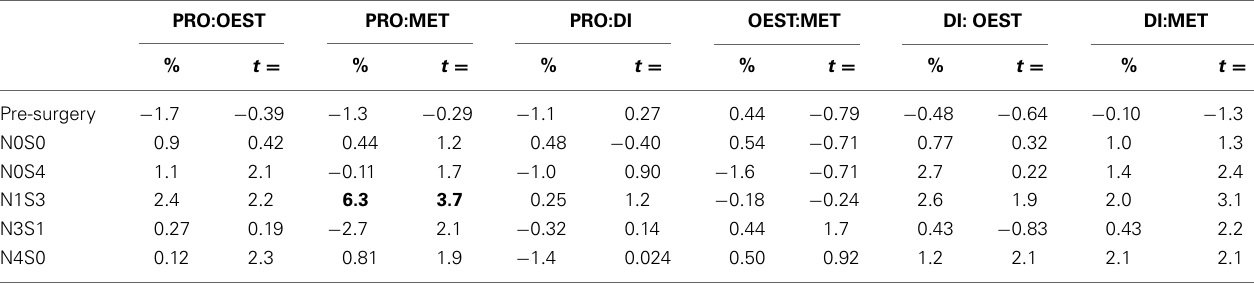
Table 3 | Traditional statistical analysis at the independent 12 g von Frey Filament for von Frey Test 2 revealed the absence of an oestrus cycle effect prior to nerve injury